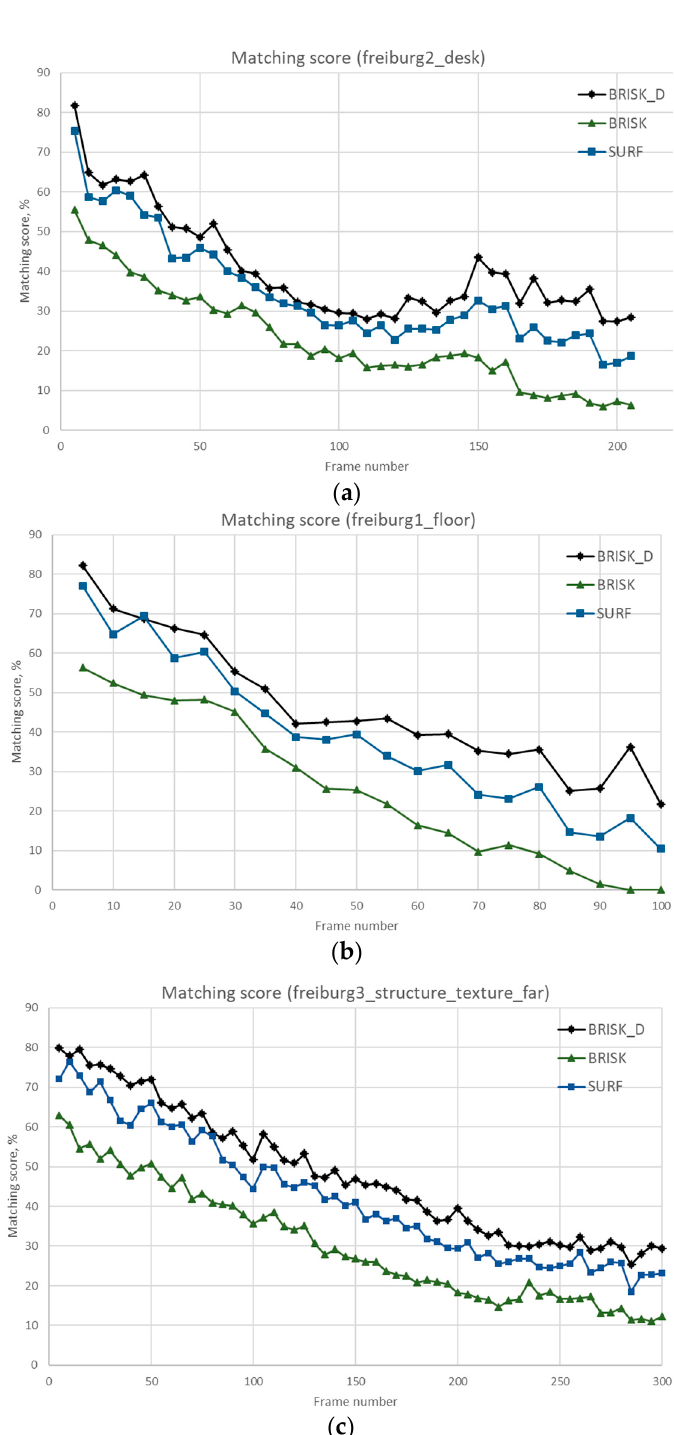
Figure 12. Images from three sequences of Freiburg dataset. ( a ) RGB image and depth image of Desk sequence ( b ) RGB image and depth image of Floor sequence ( c ) RGB image and depth image of structure texture far sequence.